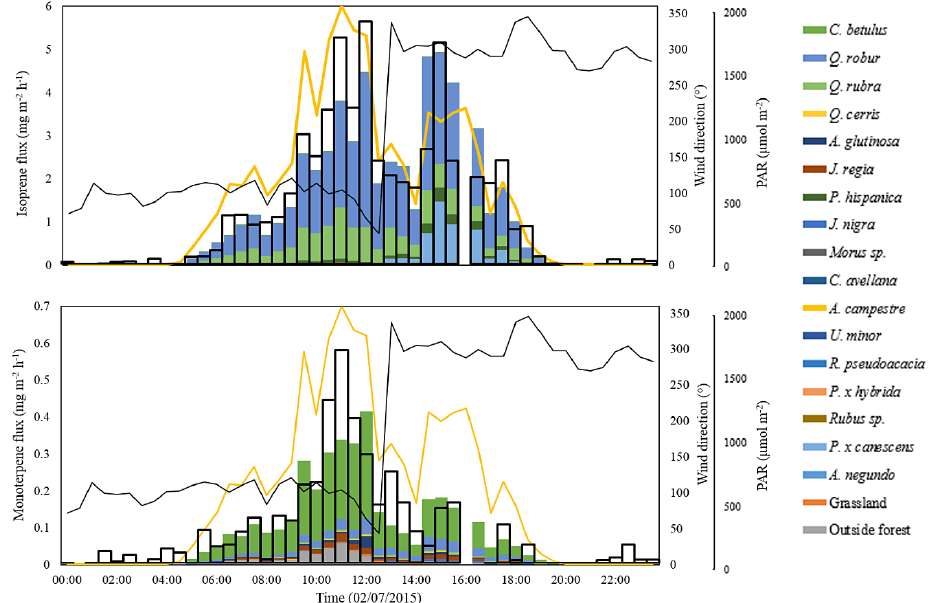
Figure 11. The contribution of individual tree species to the speciated isoprene and monoterpene flux on the 2 July 2012. PAR is displayed as a yellow line, wind direction as a black line and the flux recorded using the PTR-MS as bold black bars. Table 6. Species-specific isoprene and monoterpene emission factors (for a standard temperature of 30 ◦ C and a PAR value of isoprene and monoterpene fluxes within the constraints